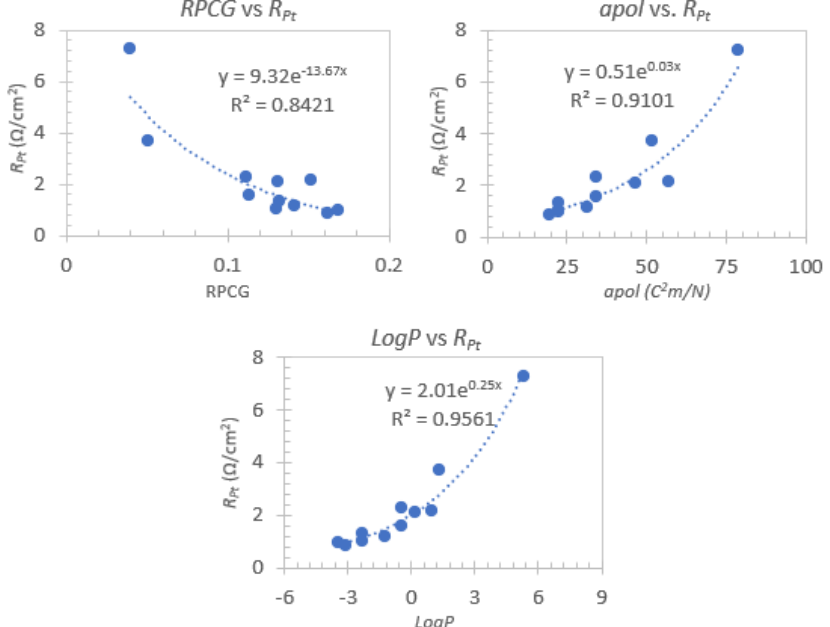
Figure 6. Exponential correlations between the counter-electrode resistance ( R Pt ) and the relative positive charge ( RPCG ), molecular polarizability ( apol ) and partition coefficient ( logP ) descriptors for the 4-TBP free set.